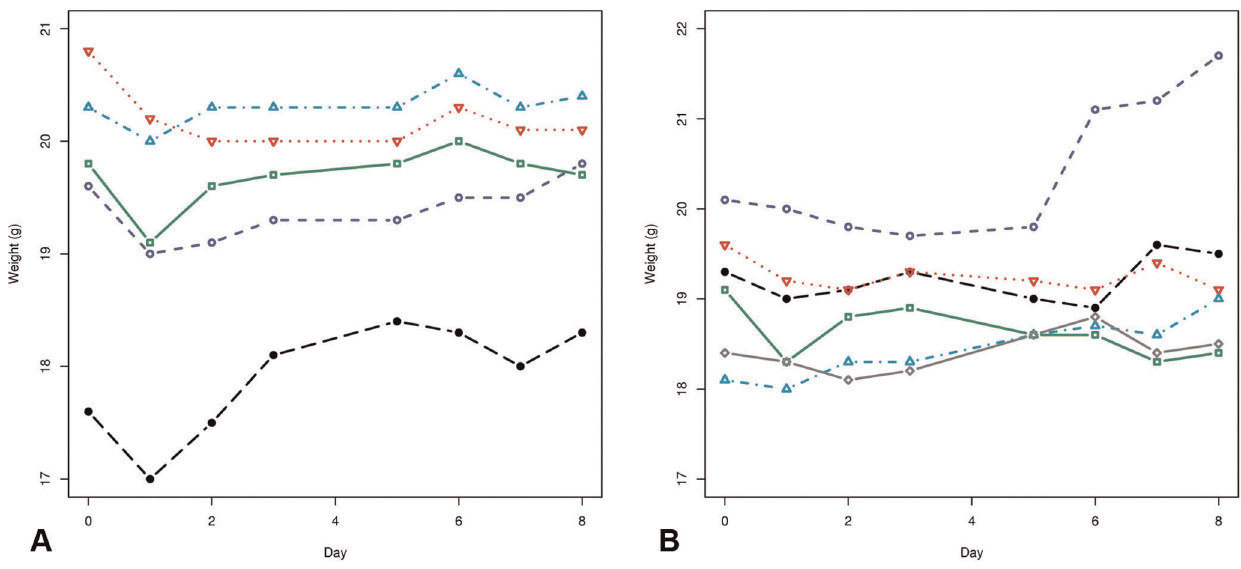
Figure 2. Safety assay of LLP2A-HYNIC in mice. A. Weight (g) of five mice treated with 10 m g/100 m L LLP2A-HYNIC over 8 days. B. Weight (g) of six mice treated with 100 m g/100 m L LLP2A-HYNIC over 8 days.